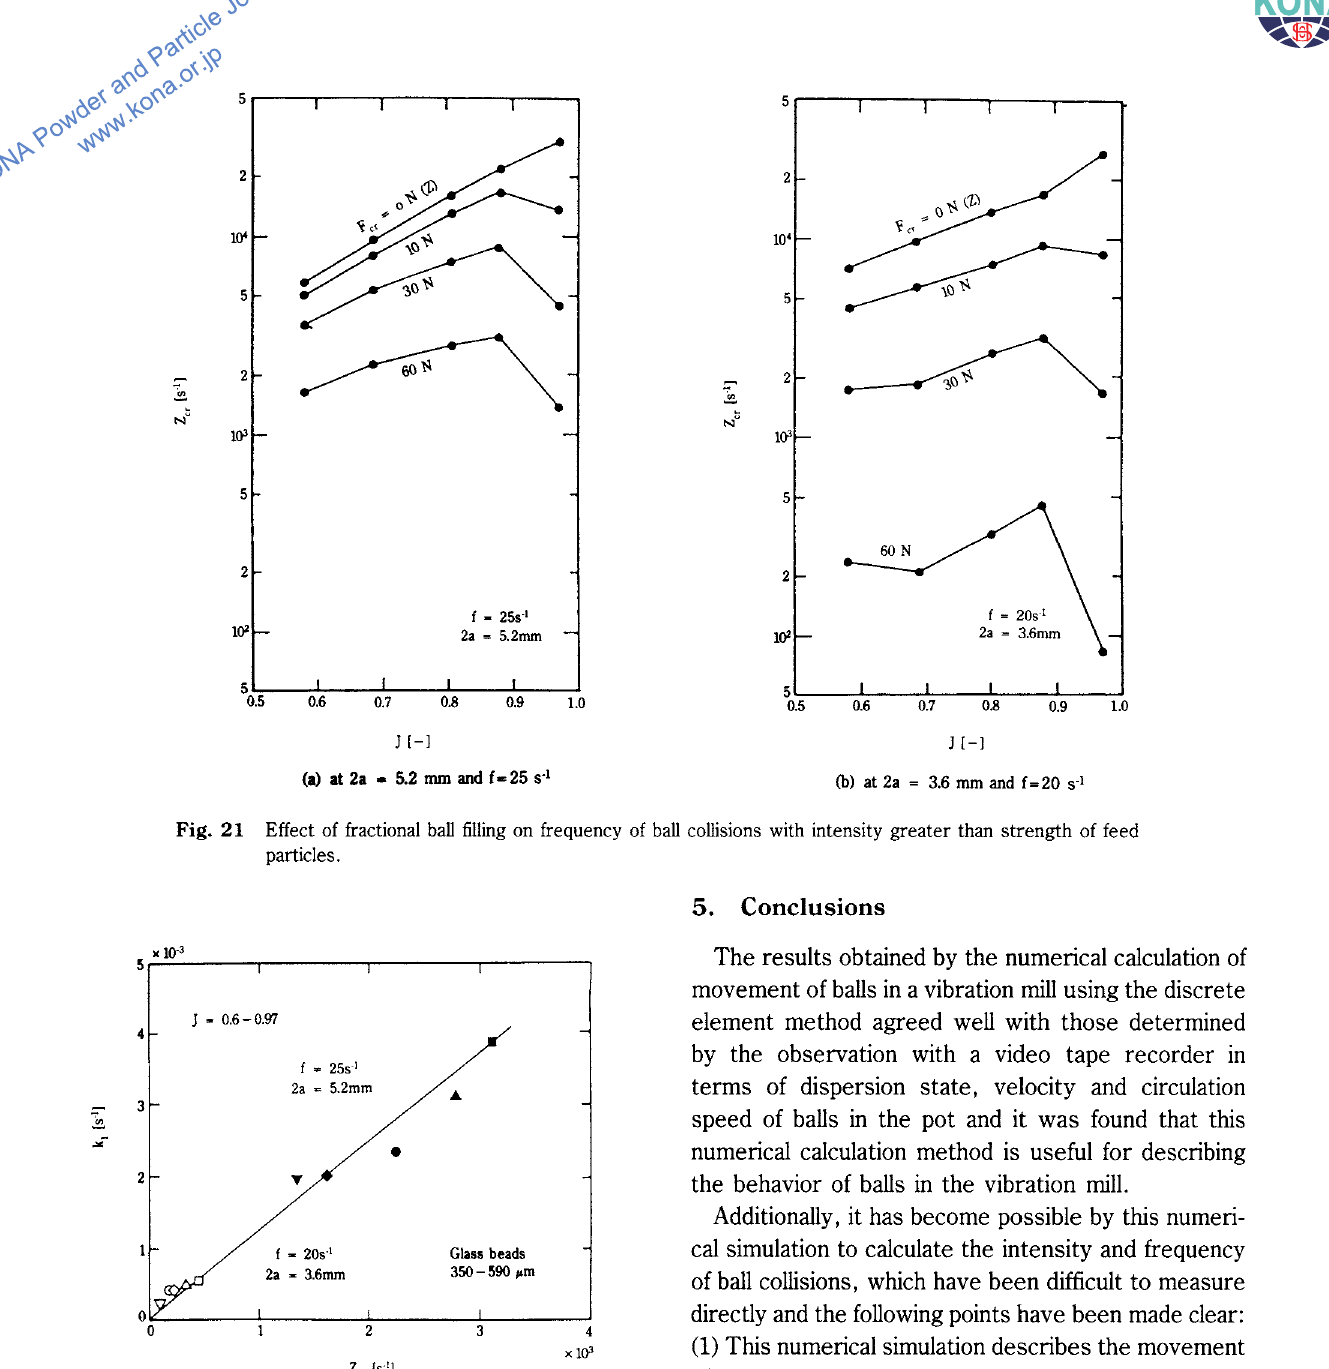
Fig. 22 Relation between rate constant of grinding and frequency of ball collisions effective to crush feed particles. (Keys as for Fig.